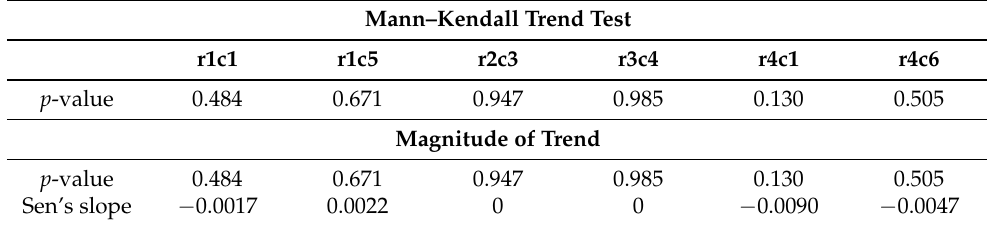
Table 1. Trend testing for selected grid points